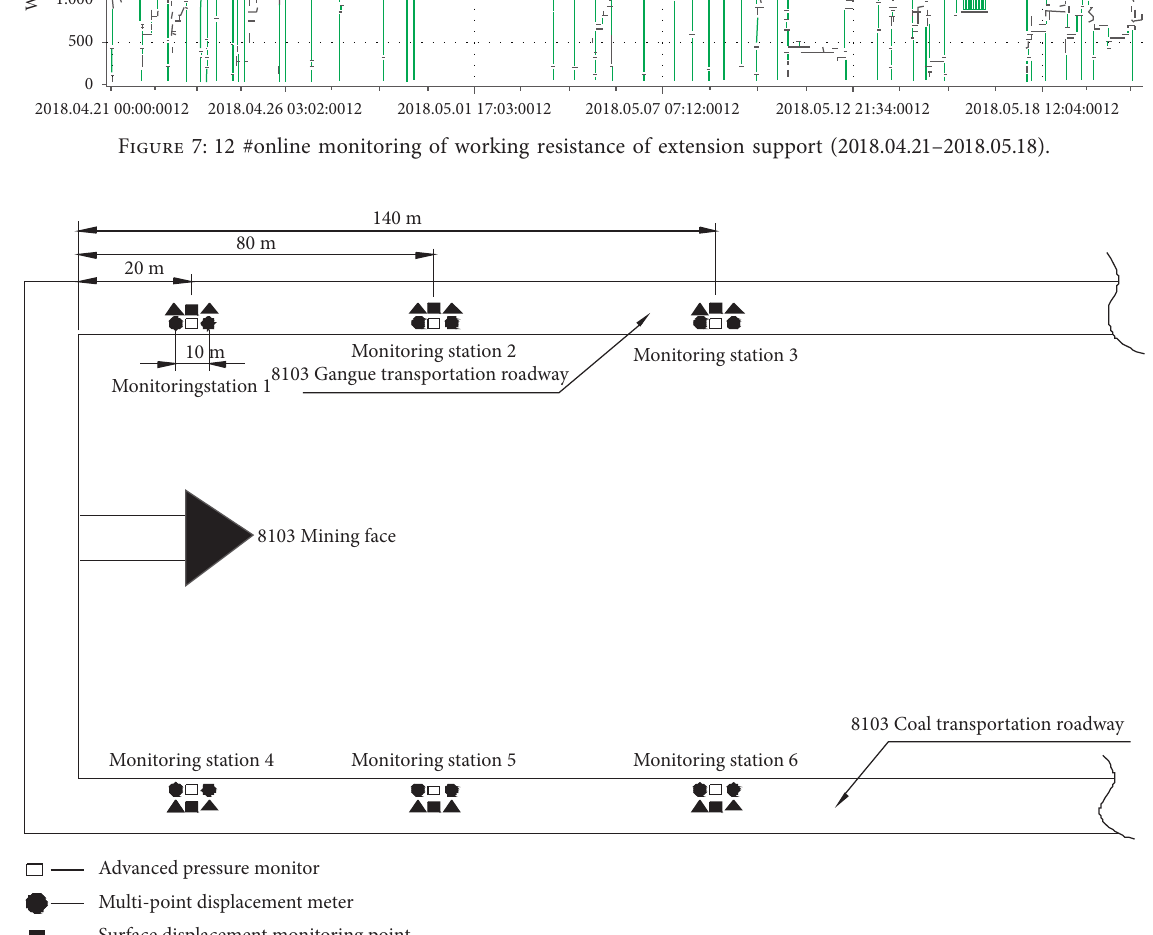
Figure 8: Layout of monitoring equipment in working face